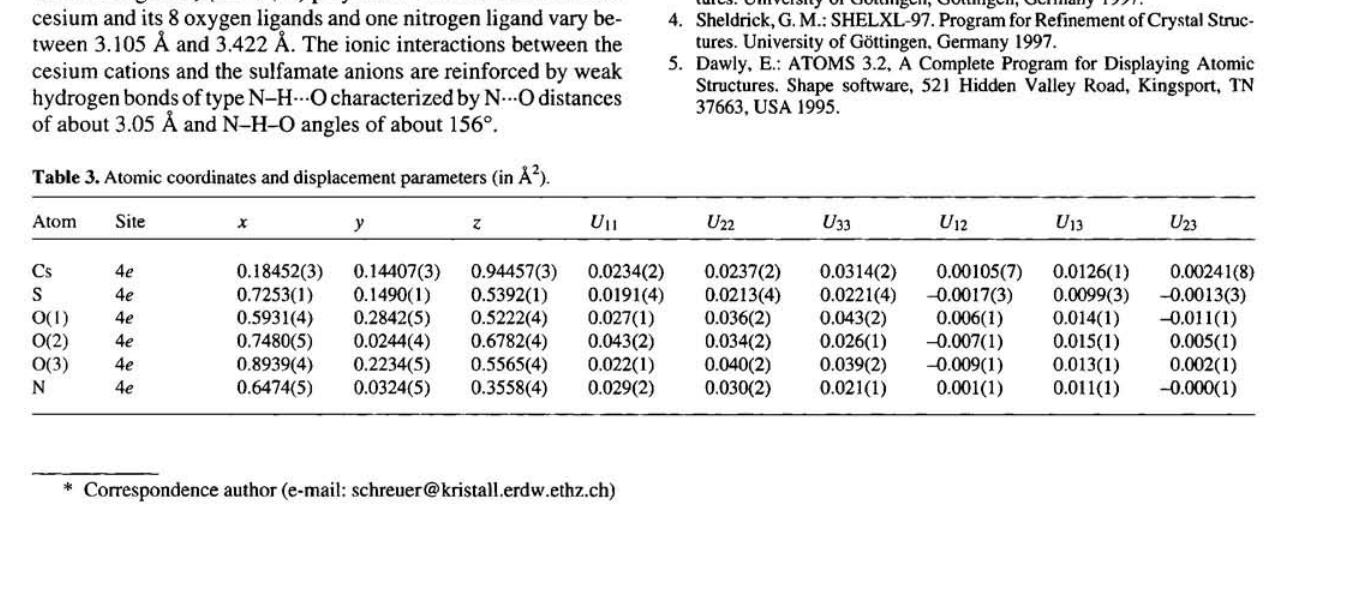
Table 2. Atomic coordinates and displacement parameters (in /